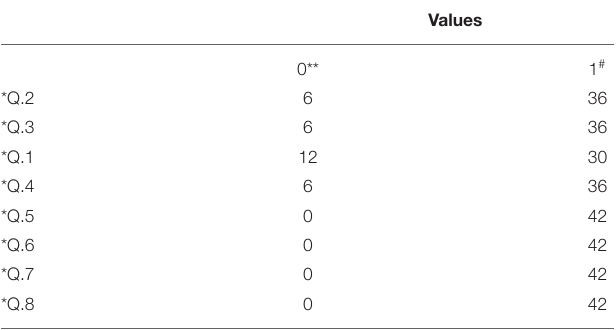
TABLE 2 | Frequencies after the virtual support program.